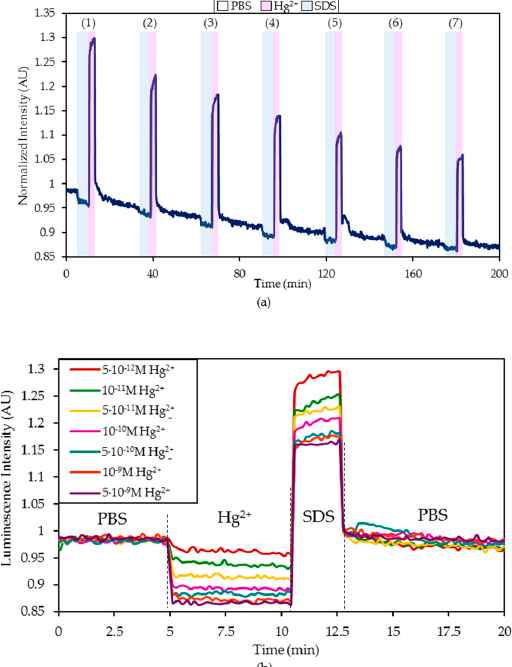
Figure 4. ( a ) Dynamic variation of the normalized luminescence intensity under 5 min exposure to different Hg 2+ concentrations ((1) 5 × 10 − 12 M, (2) 10 − 11 M, (3) 5 × 10 − 11 M, (4) 10 − 10 M, (5) 5 × 10 − 10 M, (6) 10 − 9 M, (7) 5 × 10 − 9 M), 2 min regeneration with 0.5% w / w SDS and 20 min stabilization in